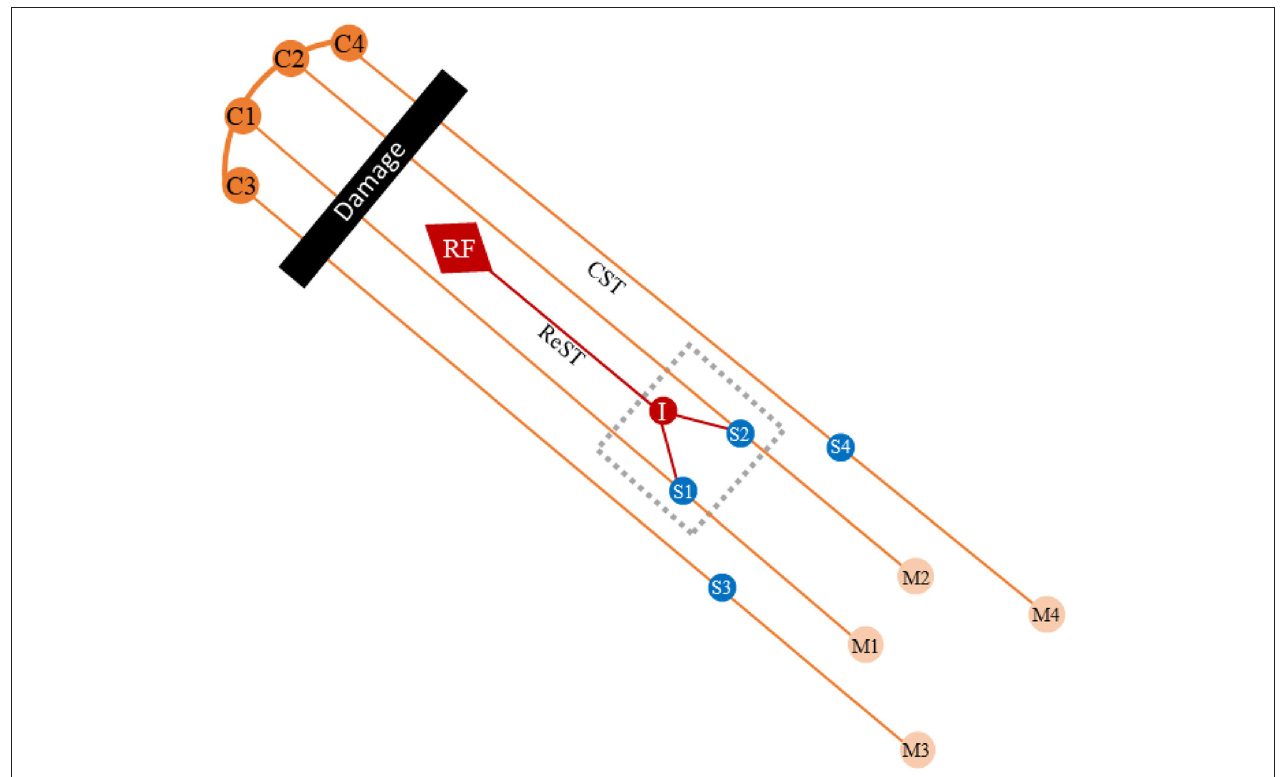
FIGURE 4 | Diagram of upper limb’s synergistic movements after stroke. The black bar represents the damage of the CST after stroke. The gray dotted frame represents a motor module (MM). The S1 and S2 represent the spinal motor neurons innervated proximal muscles of the upper limbs. The extrapyramidal system activates spinal motor neurons innervating the proximal muscles of the upper limb via interneurons, while the neurons innervating the distal muscles cannot be activated. C, cortex; RF, reticular formation; ReST, reticulospinal tract; CST, corticospinal tract; I, interneuron; S, spinal motor neuron; M,